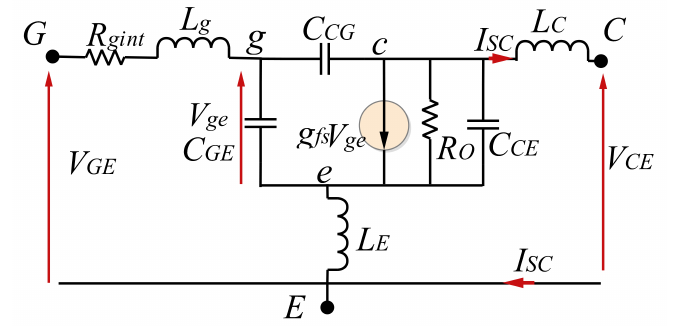
Figure 7. The simplified IGBT model valid in active